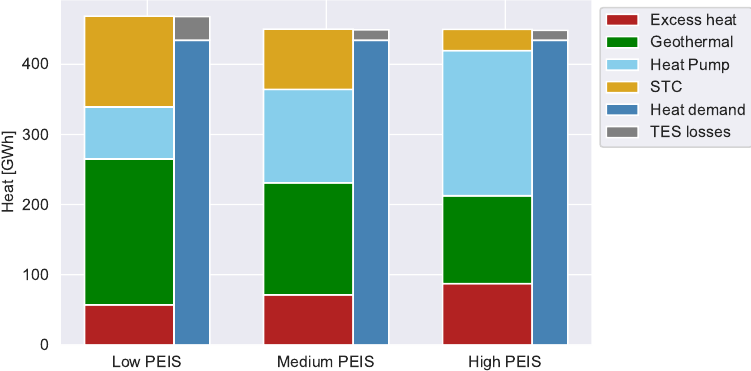
Figure 15. Summary of heat delivery for the three highlighted